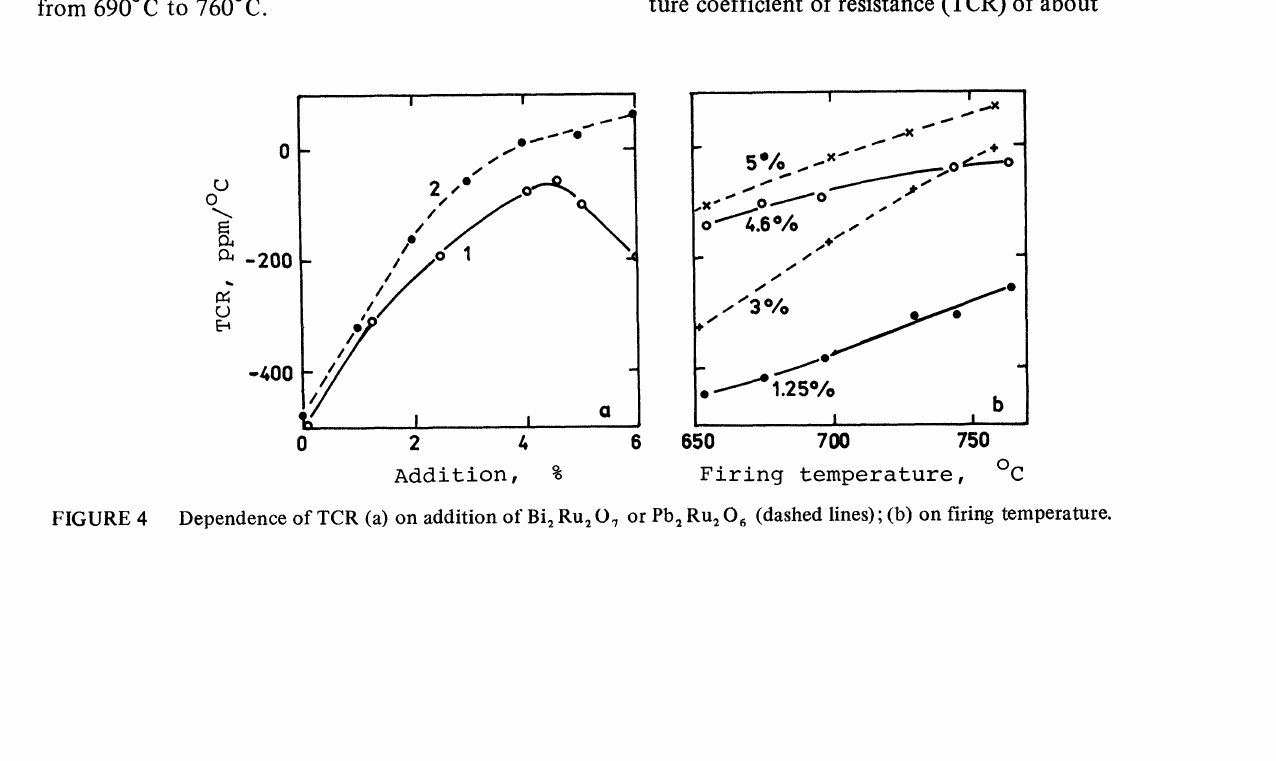
FIGURE 2 Resistance change at 120C after 1000 hours. Curve 80% EV 6 glass + 20% CdO; curve 2- 80% EV 12 glass + 15.4% CdO + 4.6% Bi Ru O